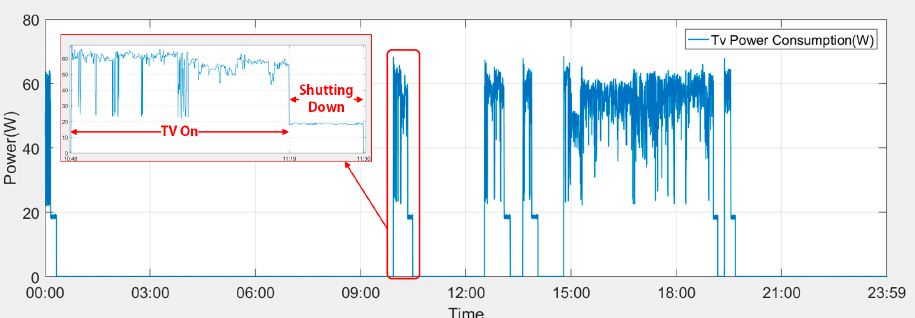
Figure 17. The power consumption curve of the television.